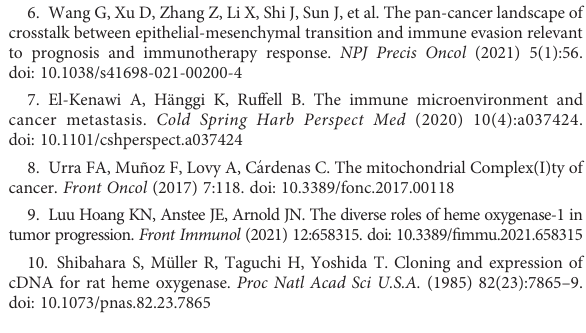
SUPPLEMENTARY FIGURE 9 Identifying the molecular structure of 9 small component drugs targeting the HMOX1-mediated LUAD metastasis by